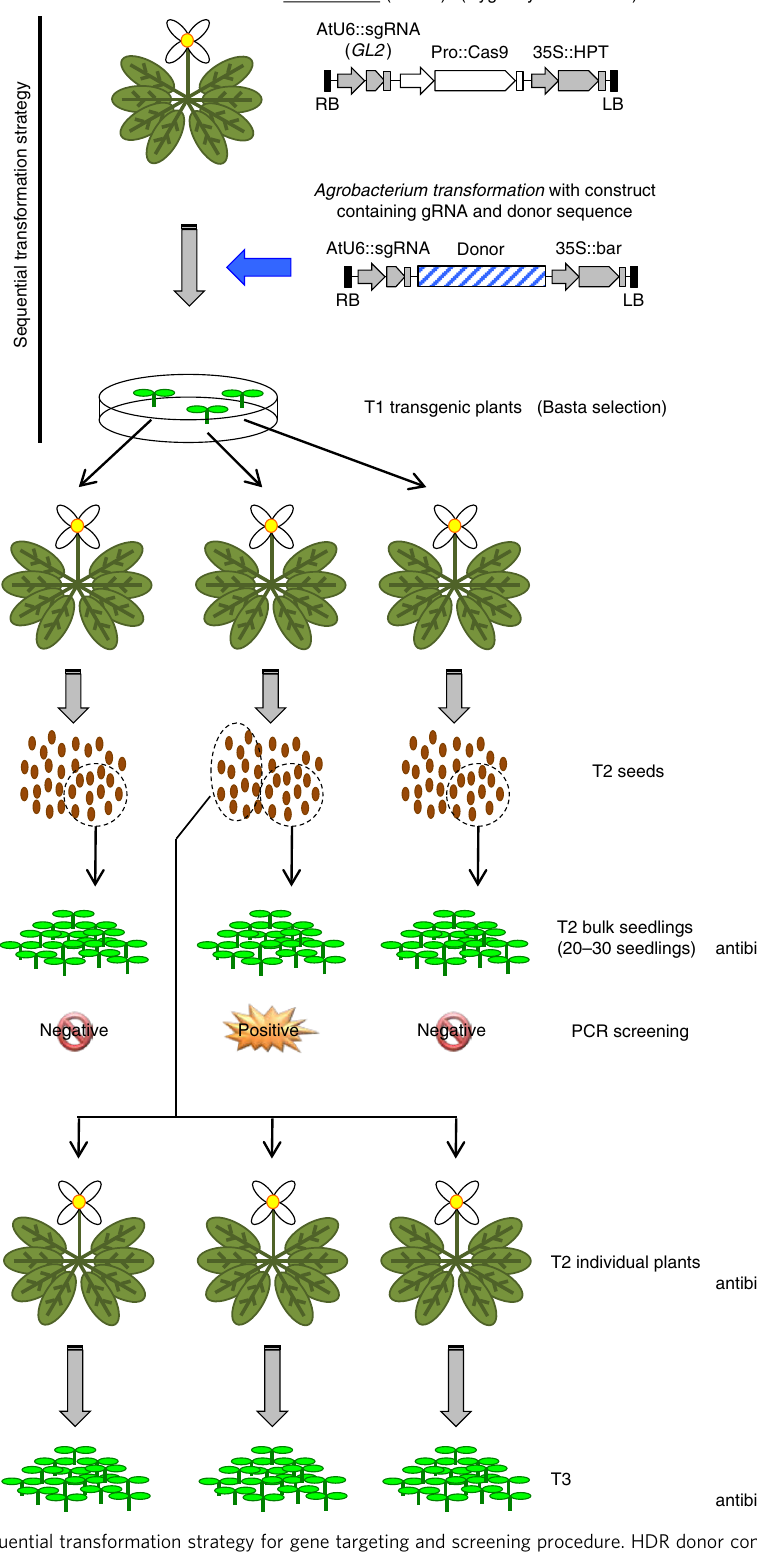
Fig. 1 Outline of the sequential transformation strategy for gene targeting and screening procedure. HDR donor constructs containing a selection marker and sgRNAs targeting genes of interest were transformed into parental lines, which were already transgenic for an incidental GL2 -targeting sgRNA and, importantly, for Cas9 driven by a speci fi c promoter. T1 transgenic lines were selected with Basta, and T2 seedlings were obtained and analyzed in bulk. The positive lines were used for further experiments with individual T2 plants. Portions of the images were obtained from the Microsoft PowerPoint clip art data